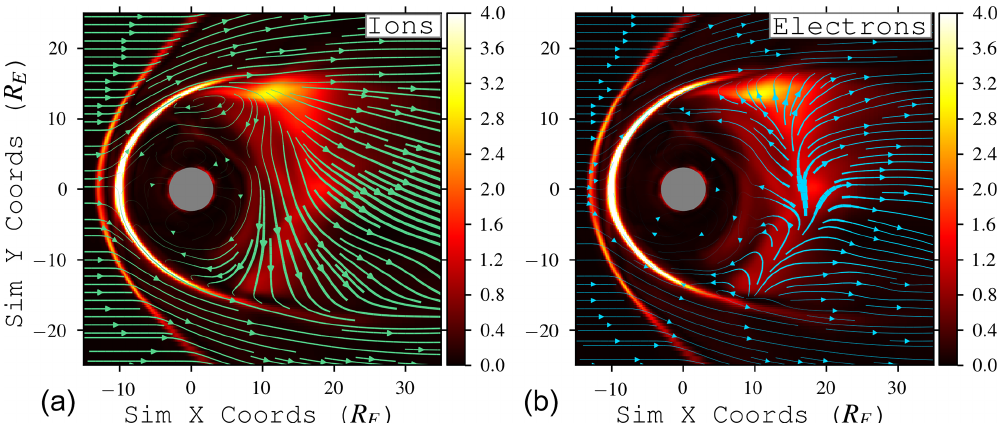
Figure 4. Cross-tail convection in the reconnection plane at z = 0 for ions (a) and electrons (b) , with the background color (orange) illus- trating normalized current sheet density magnitude. Blue (green) streamlines indicate direction of electron (ion) velocity (normalized via v 0 = 97 . 9kms − 1 ), with line sizes proportional to the magnitude of the maximum electron (ion) velocity in the plane. The electron velocity (in normalized units) is calculated from v e = v − J /ρ